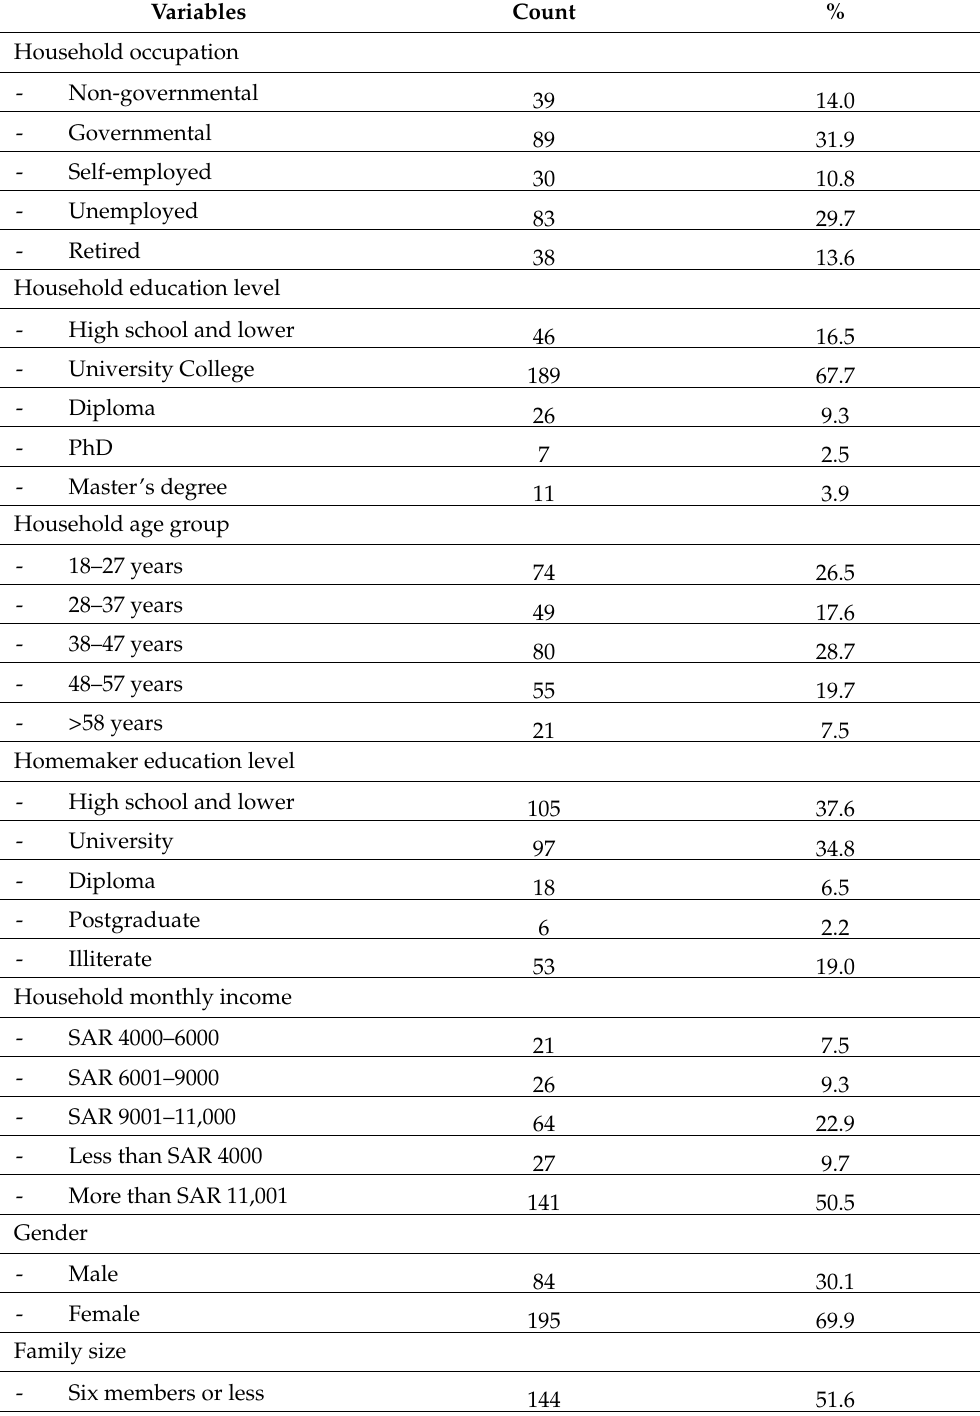
Table 1. Socio-demographic characteristics of the study participants ( n =